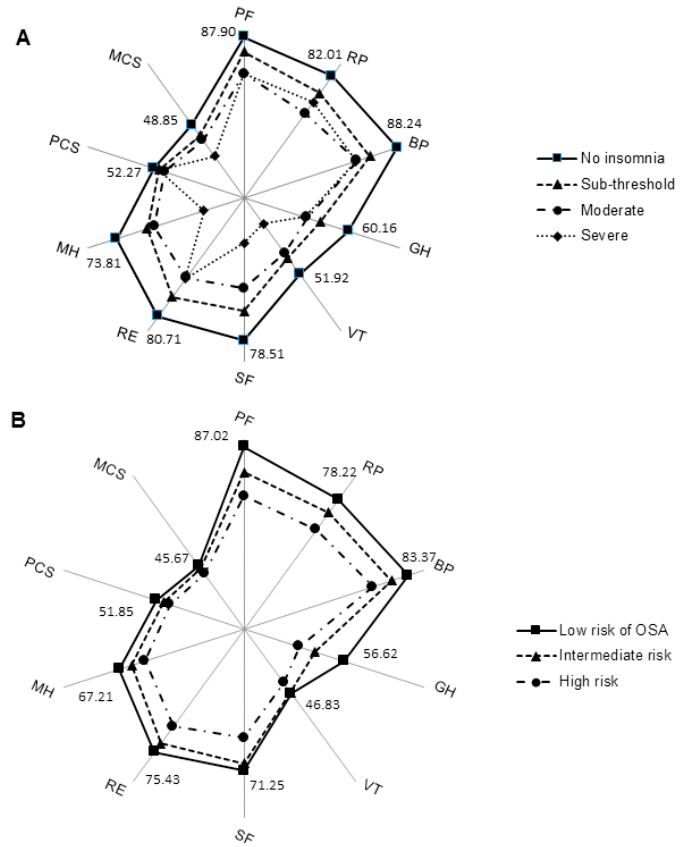
Figure 1. The mean values of the different SF-12 subscales across insomnia-severity groups ( A ) and apnea-severity groups ( B ). PF—physical functioning; RP—physical role; BP—bodily pain; GH—general health; VT—vitality; SF—social functioning; RE—emotional role; MH—mental health; PCS—physical component summary; MCS—mental component summary; OSA—obstructive sleep apnea.